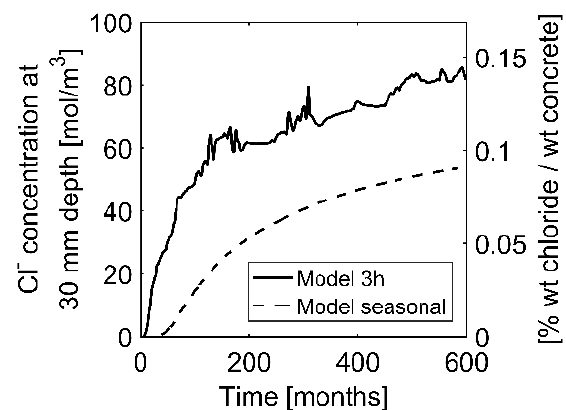
Figure 1. Prediction of chloride concentration at 30 mm depth over 50 years using a coupled heat and mass transport model applying detailed meteorological data (per 3 h) or averaged seasonal data. After